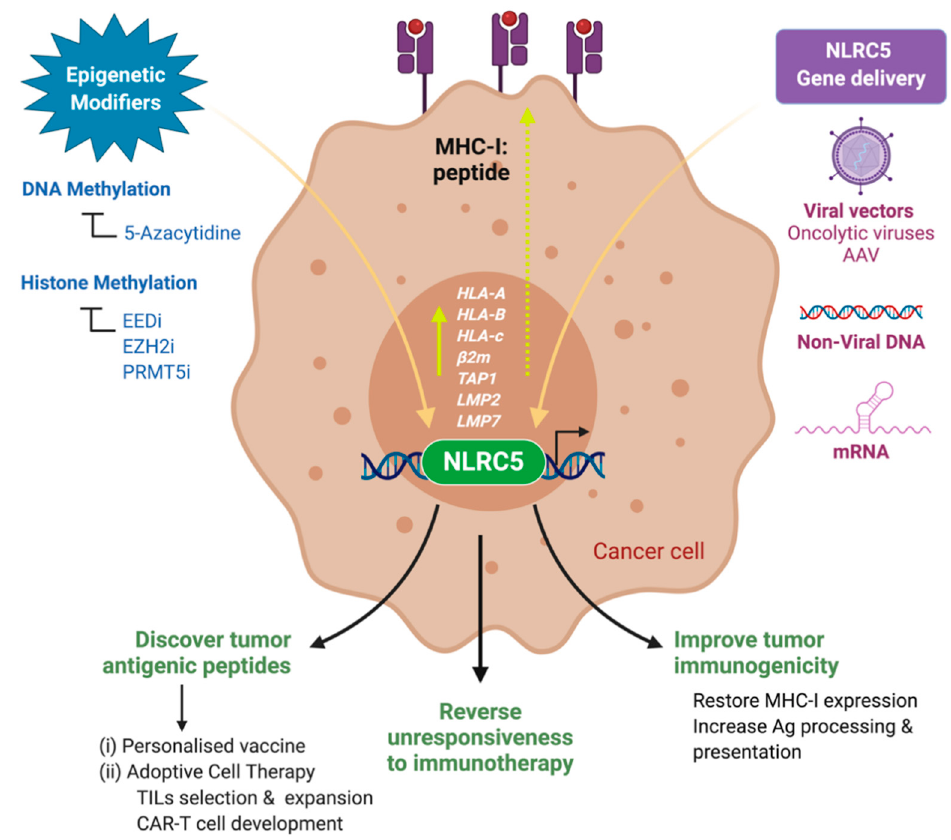
Figure 4. Strategies to restore NLRC5 expression in cancer cells and its potential applications for cancer immunotherapy. MHC-I low cancers can be treated with pharmacological agents to relieve epigenetic repression of NLRC5 that will also derepress MHC-I and APM genes. NLRC5 gene delivery using oncolytic viruses, naked DNA or mRNA will be useful on cancers with a dysfunctional NLRC5 gene. Restoration of NLRC5 can be exploited to improve tumor immunogenicity and CTL-mediated killing, and to reverse unresponsiveness to conventional cancer immunotherapy such as immune checkpoint inhibitors. NLRC5 can also be exploited for cancer neoantigen discovery that will find application in personalized cancer vaccines and adoptive cell